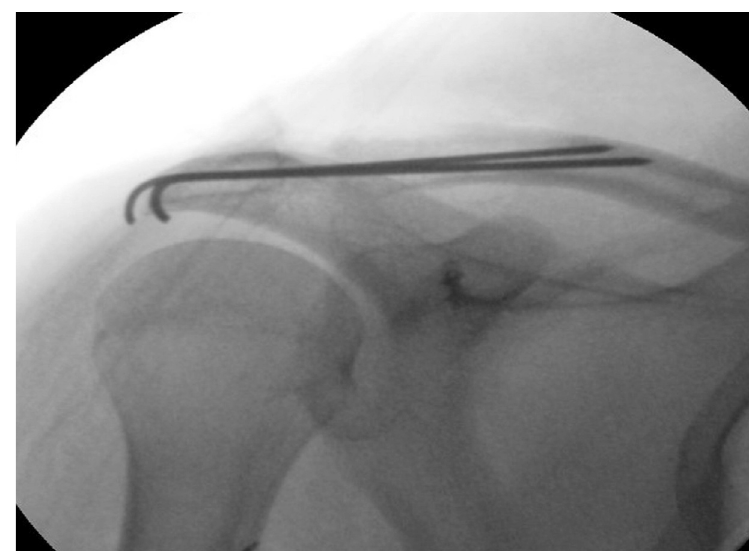
Fig. 1: Fluroscopic image showing transfixation of ACJ with K wires and position of suture anchor in the coracoid process.